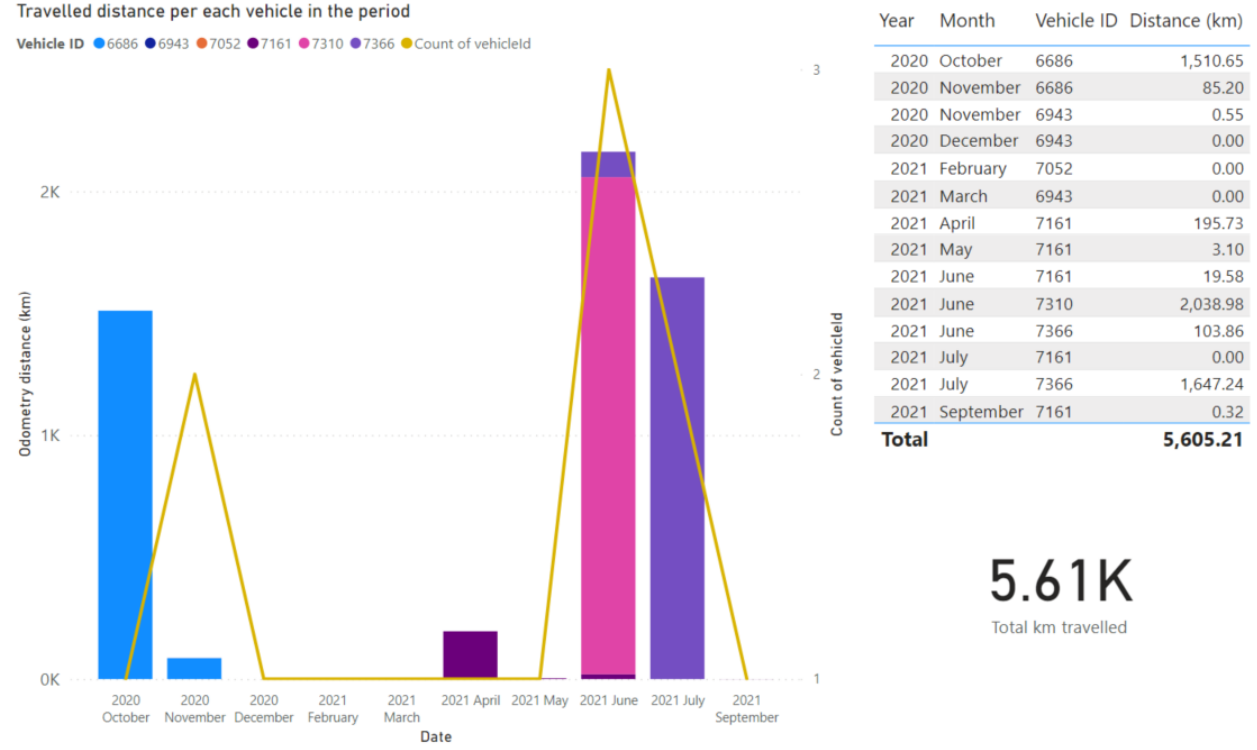
Figure 8. Mobility dashboard for the evaluation of the travelled